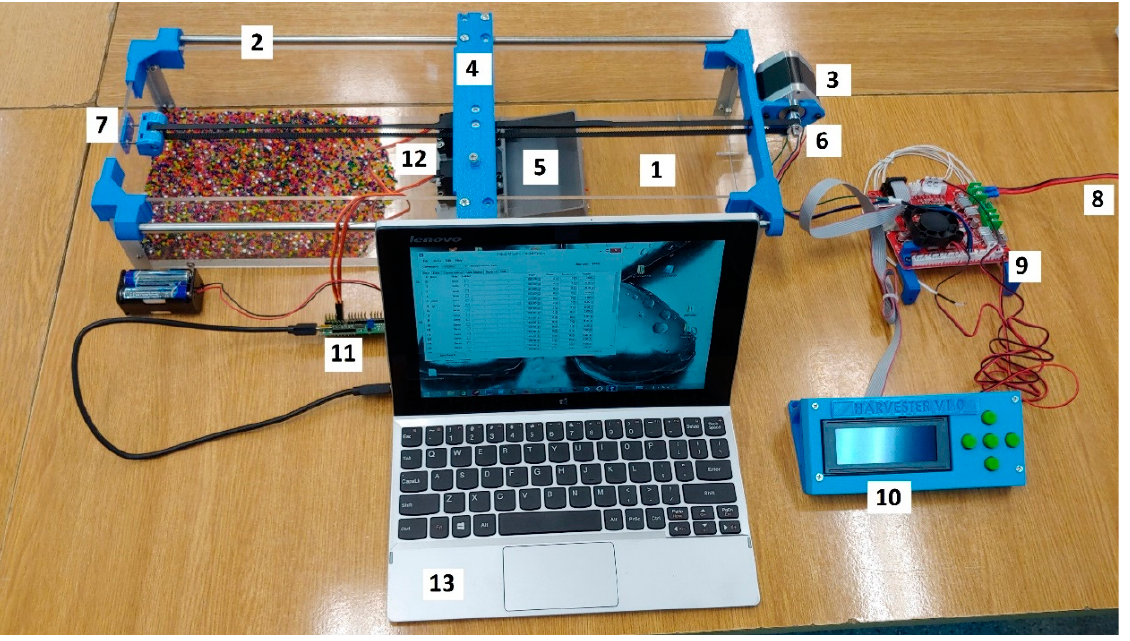
Figure 9. Test stand with equipment: 1—plexiglass box, 2—linear guide, 3—stepper motor, 4—supporting beam, 5—harvester, 6—belt transmission, 7—adjustable tensioner, 8—power supply, 9—microcontroller, 10—control box with display, 11—servo controller, 12—servo motors, 13—PC.